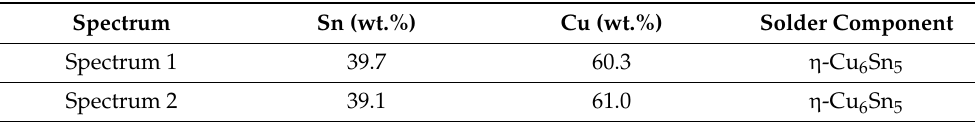
Measurement in this zone was performed at two points, Spectra 1 and 2. The results Table 8 . Point EDX analysis of the boundary in the Cu–SiC/Sn5Sb3Ti joint . of the measurement are given in Table